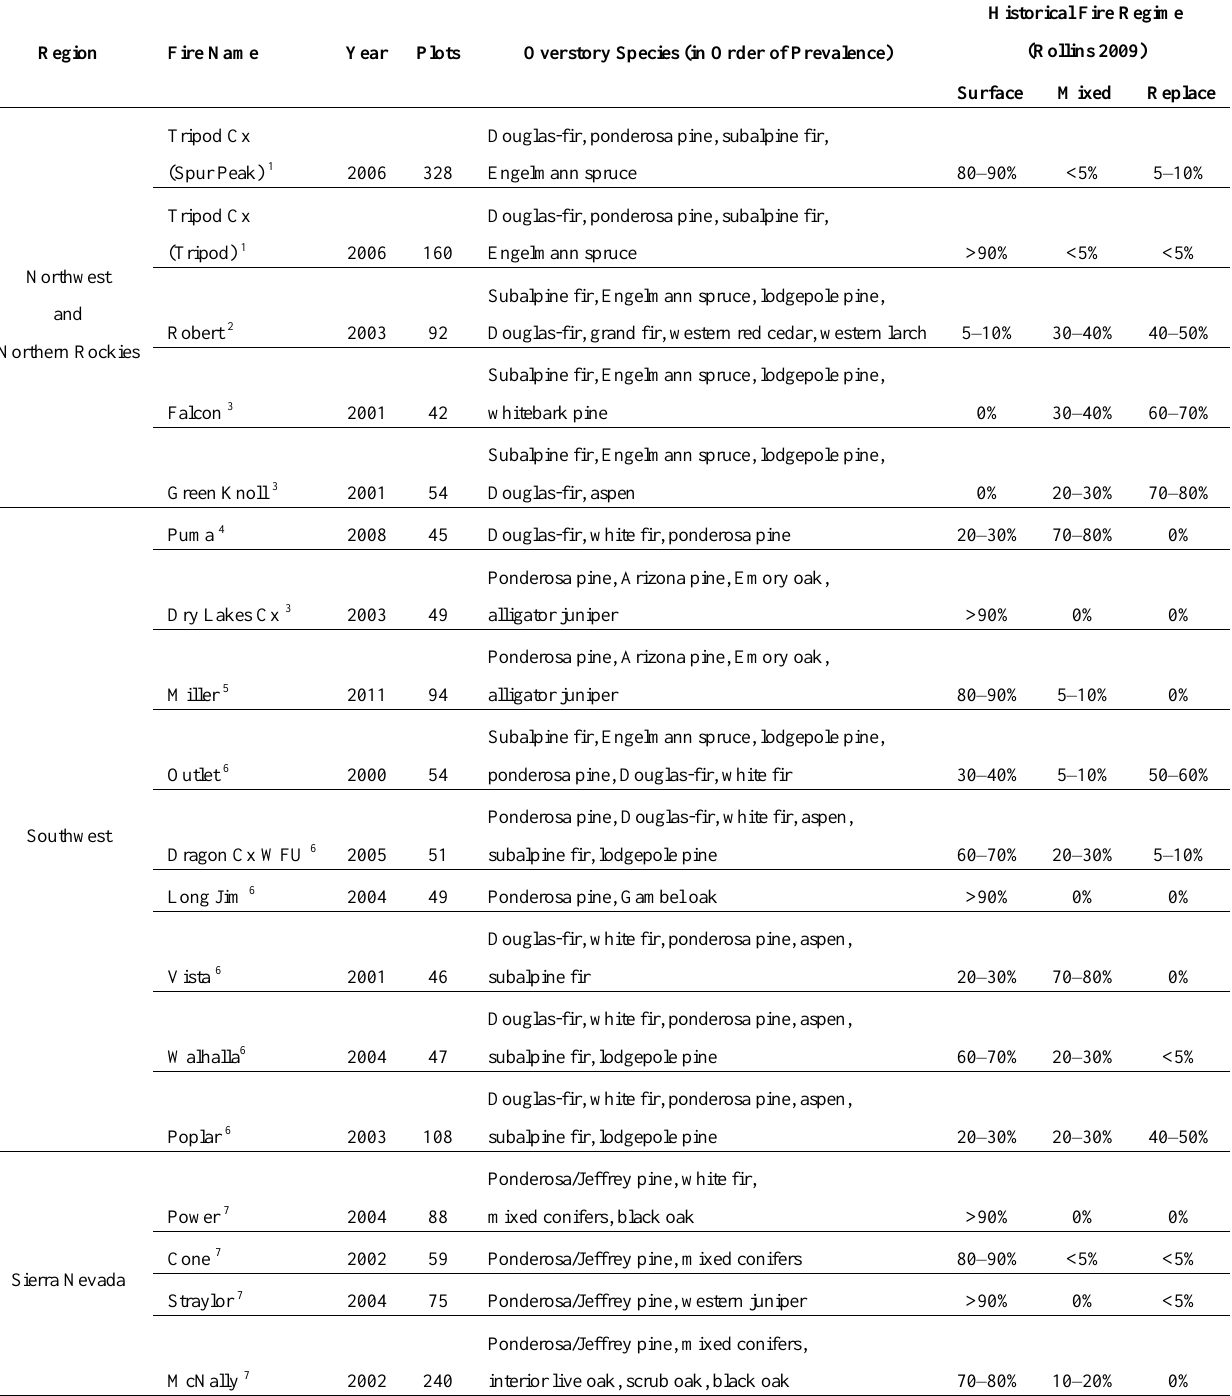
Table 1. Summary of fires analyzed in this